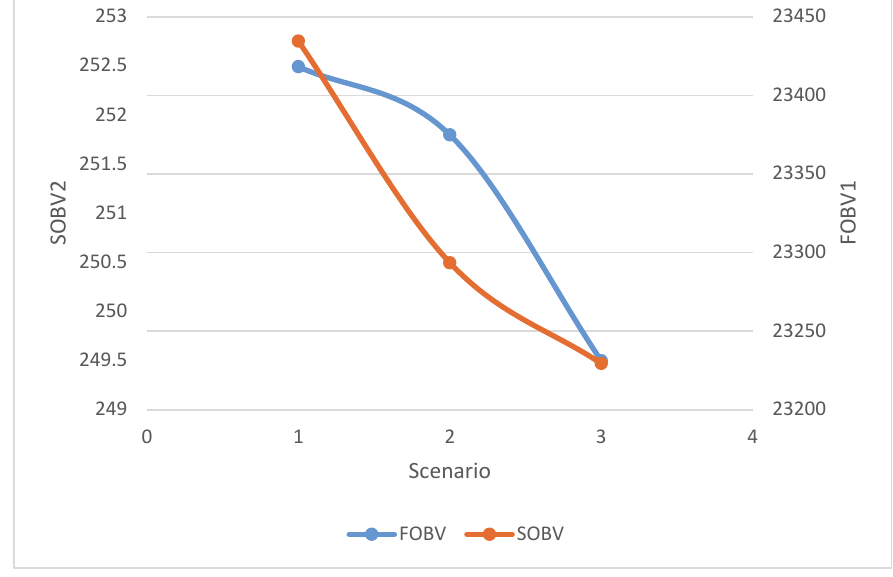
Fig. 6 . Changes in the value of the first and second objective functions by changing the number of service